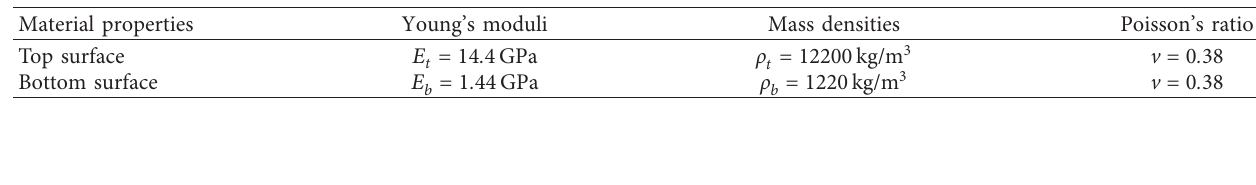
Table 3: First six natural frequencies of the FGP plate on the EFTIM (Hz).